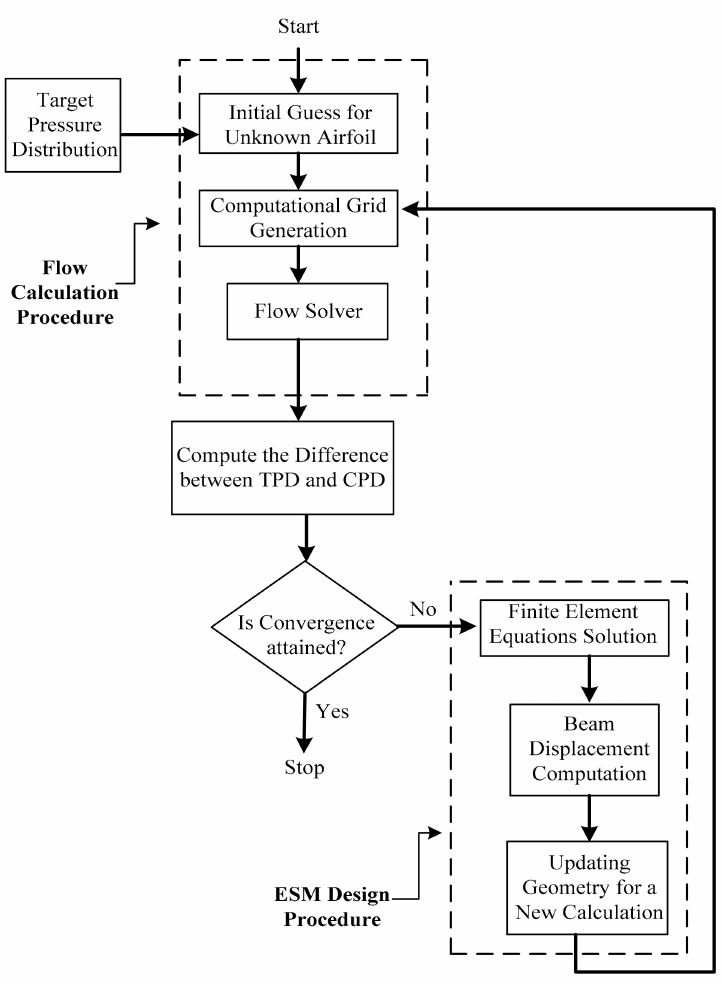
Figure 1. Basic similar flowchart of the ESA and UESA inverse design methods. The UESA is used for the inverse design of 2D cascade blades, which have sharp leading and trailing edges and sharp pressure gradients near the stagnation point. In the UESA, the blade wall deformation is modeled with the deflection curve of a Timoshenko beam, which is differentiable and smooth at all the nodes. Therefore, unlike the